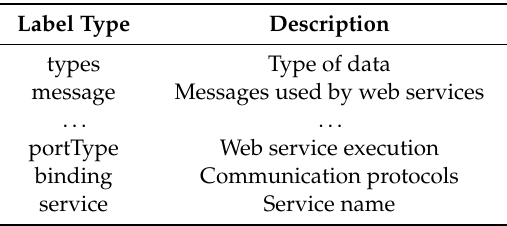
Table 1. WSDL service description